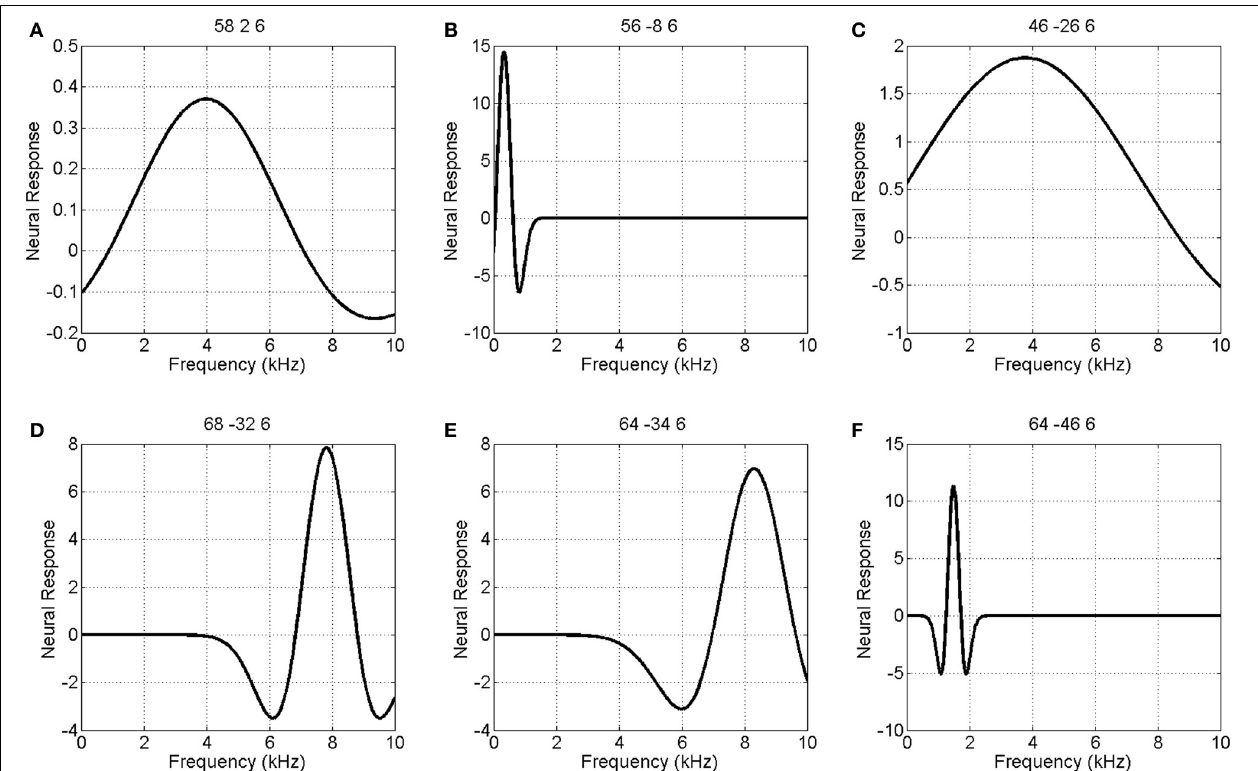
FIGURE 8 | Estimated Mexican-Hat neural response functions at six selected voxels (same voxels as in Figure 6). The labeling (A – F) refers to positions shown in the top left panel of Figure 5